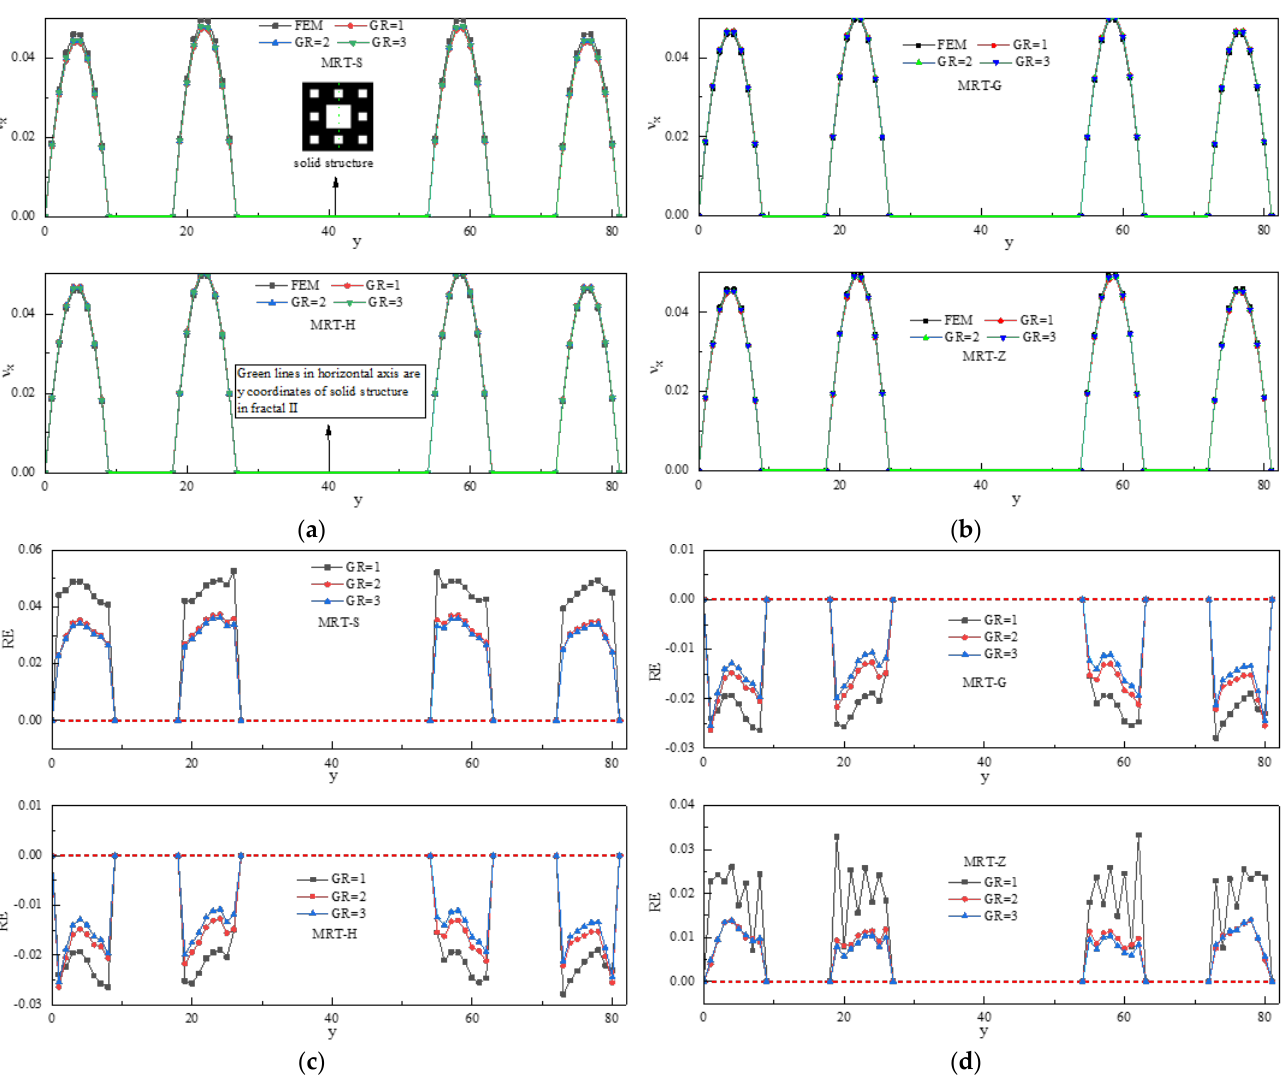
Figure 7. ( a , b ) The profiles of v x along vertical centerline of ROI (x = 140.5) in fractal II. ( c , d ) RE curves of v x along vertical centerline of ROI (x = 140.5) in fractal II.